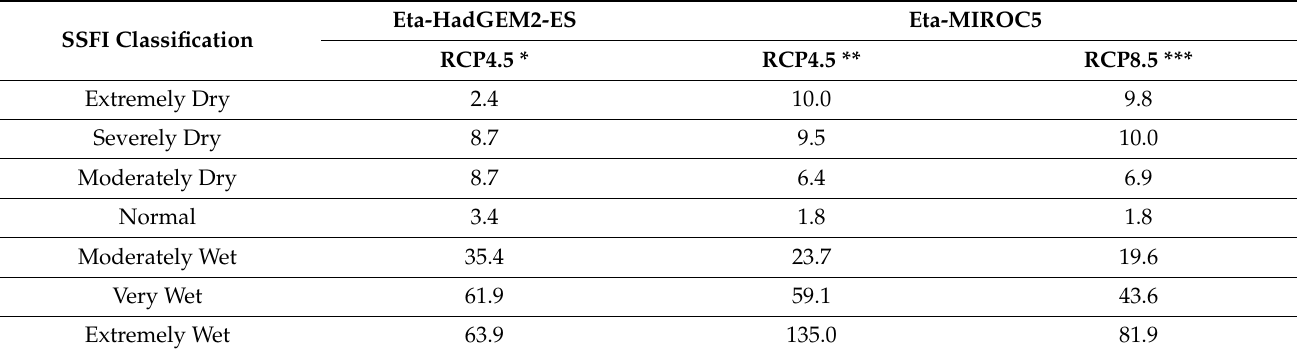
Table 5. Return period (years) for the droughts in the hydrological years projected by the Eta-HadGEM2-ES and Eta-MIROC5 coupled to the LASH model in the